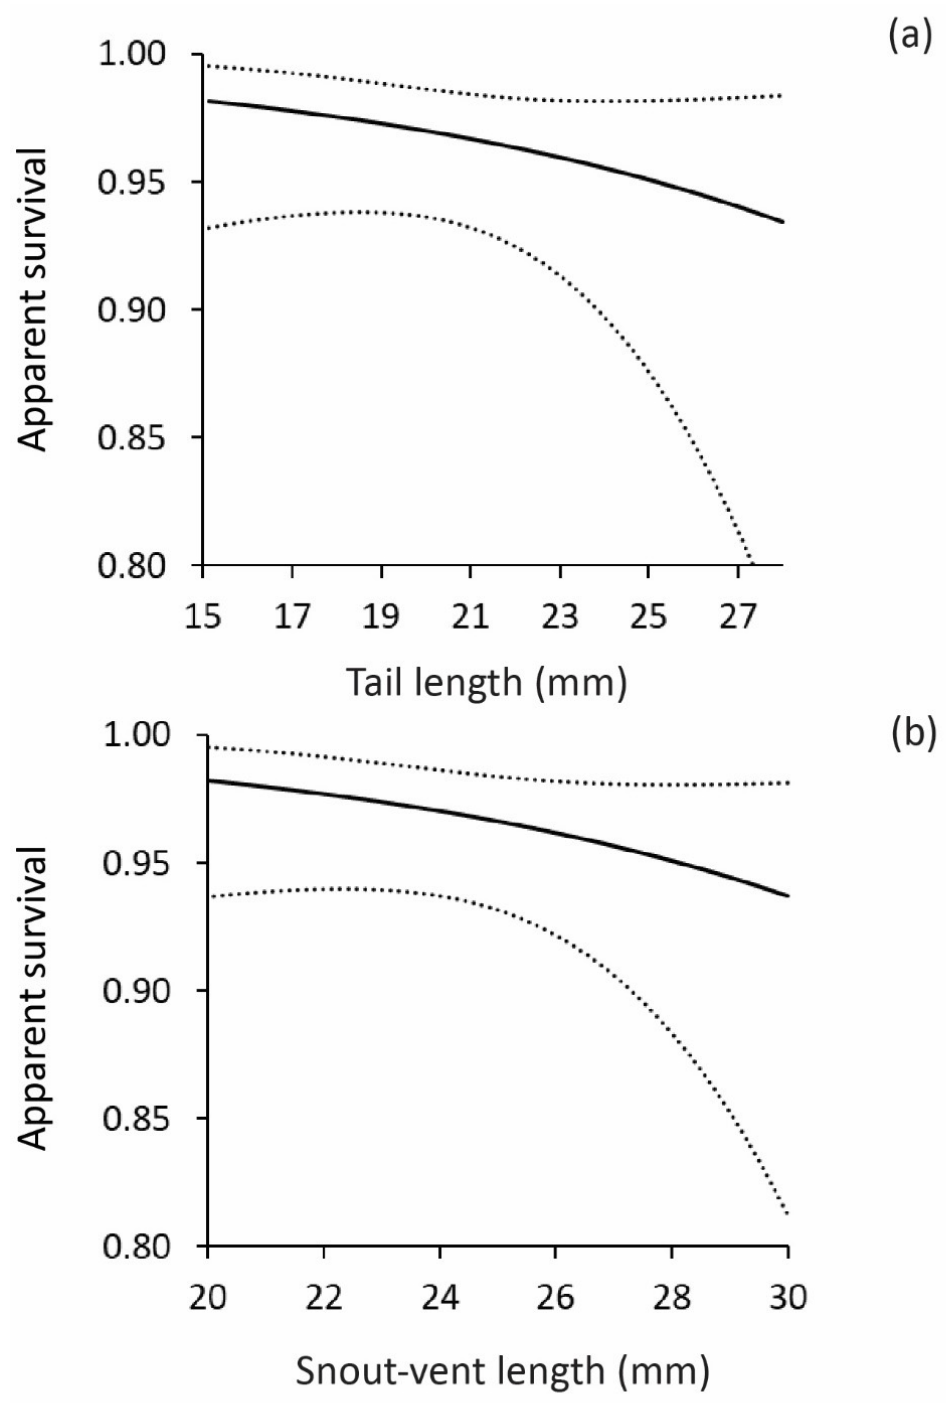
Figure 1. Relationship between apparent survival of hatchling geckos and: ( a ) tail length and ( b ) snout-vent length. Dotted lines show 95% CIs.